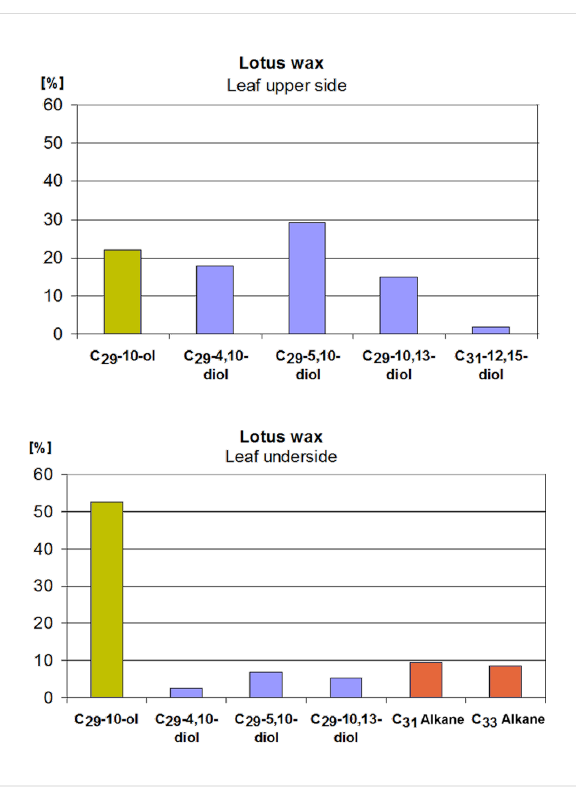
Figure 11: Chemical composition of the separated waxes of the upper and lower side of the lotus leaf. The upper side wax contains 65% of various diols and only 22% of nonacosan-10-ol (C 29 -10-ol), 13% was unidentified; the underside wax contains 53% nonacosan-10-ol and only 15% of various diols. Alkanes (18%) were only found in the under- side wax and may be an essential part of the underlying wax film.